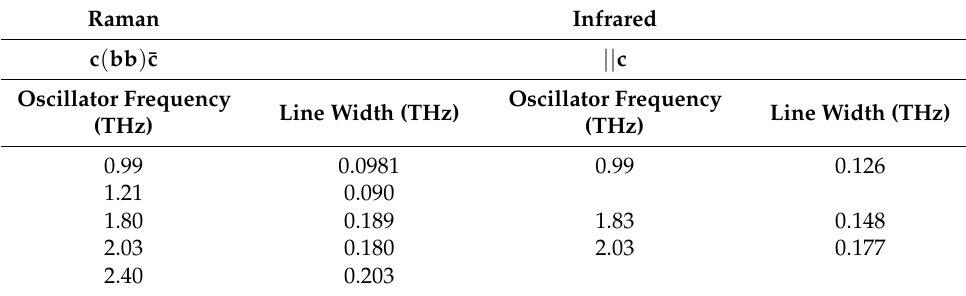
Table 26. Phonon resonances of DCMBI